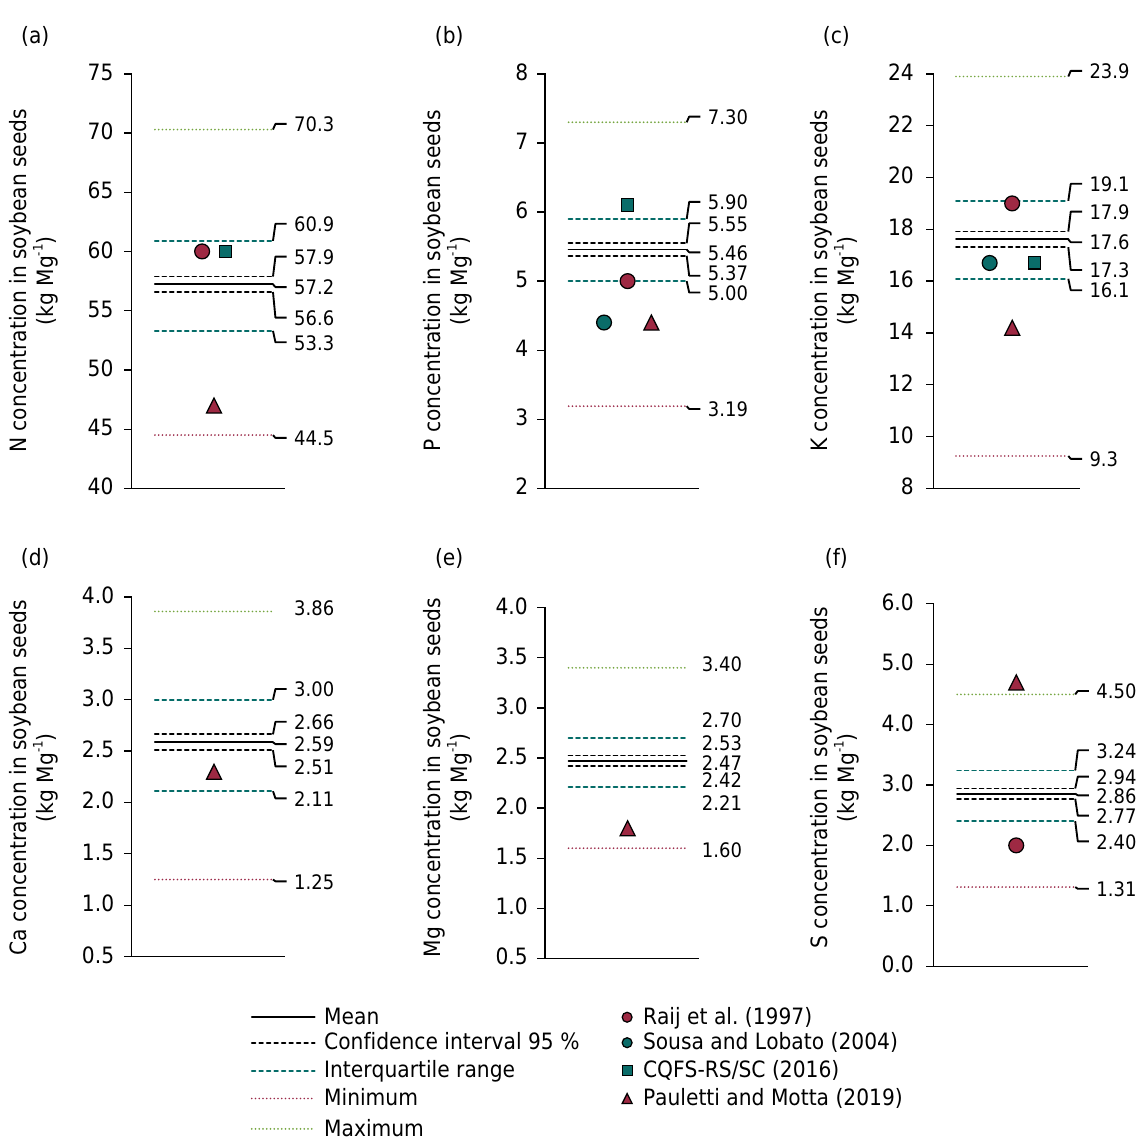
Figure 6. Comparison of updated values for N (a), P (b), K (c), Ca (d), Mg (e), and S (f) concentration in soybean seeds observed in this meta-analysis for studies published between 2015 to 2019 (lines indicating mean, confidence interval, interquartile range, maximum and minimum values) and the reference values used in the main official recommendations in Brazil. Raij et al. (1997) corresponds to the Technical Bulletin 100 for the state of São Paulo; Sousa and Lobato (2004) corresponds to the official fertilization recommendation system for the Brazilian Cerrado; CQFS-RS/SC corresponds to the official fertilization recommendation system for the states of Rio Grande do Sul and Santa Catarina; Pauletti and Motta (2019) corresponds to the official fertilization recommendation system for the state of